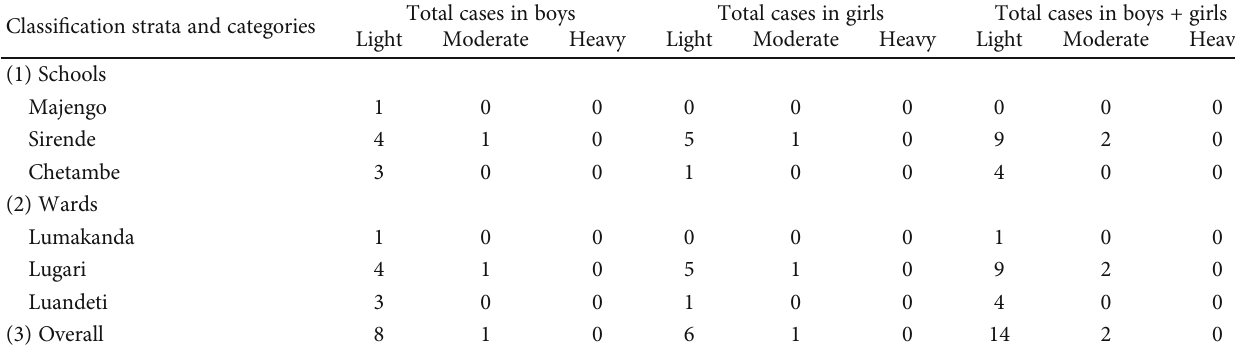
Table 4: Intensity of Ascaris lumbricoides Lugari